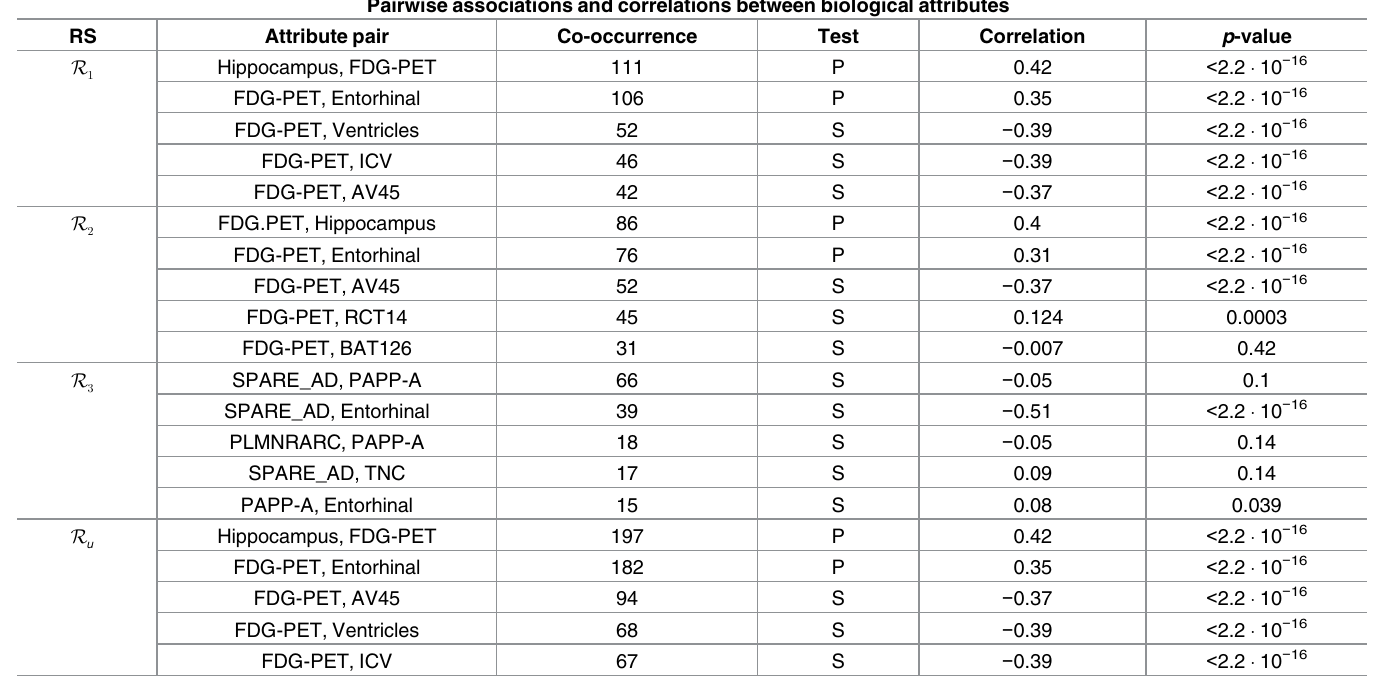
Table 7. The top five associations between pairs of biological attributes as measuredby their co-occurrence in redescription queries. Attribute cor- relationsfor a redescription set R are computedon dataset D i . P denotes the Pearson correlationcoefficient and S denotesthe Spearman’s correlationcoeffi- i ¼ R [ R [ R cient. R . Correlationsfor attribute pairs from the redescriptionset R 1 2 3 u Pairwise associations and correlations between biological